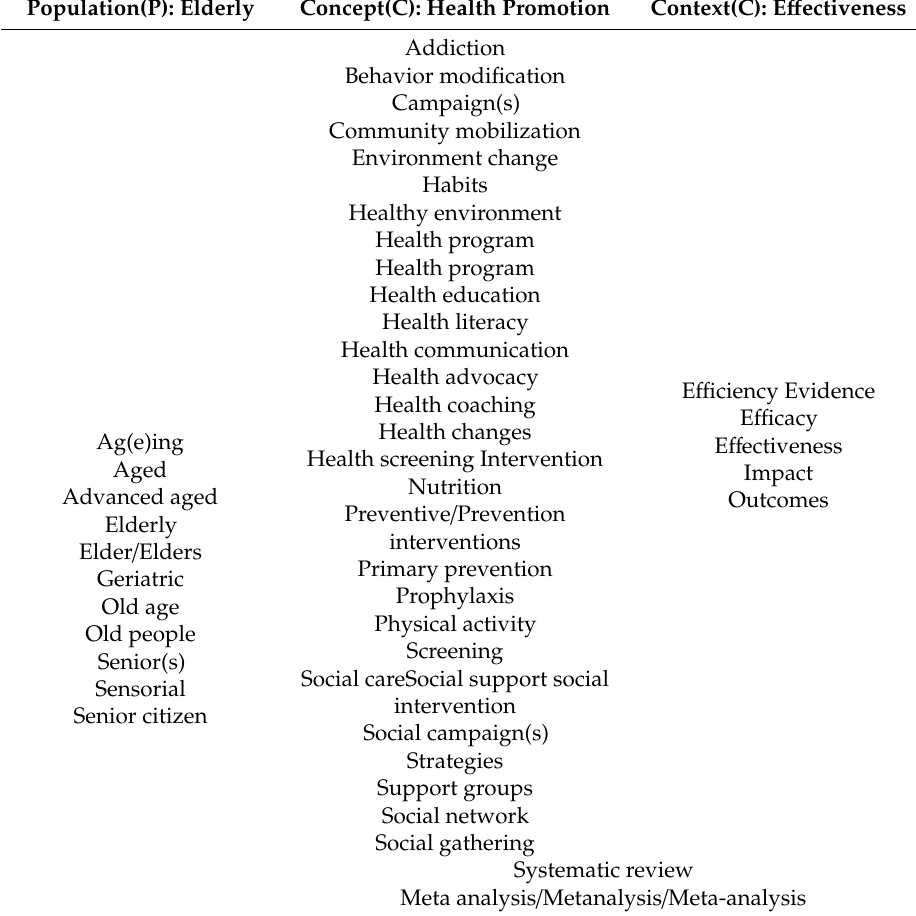
Table 1. Keywords used in the search related to health